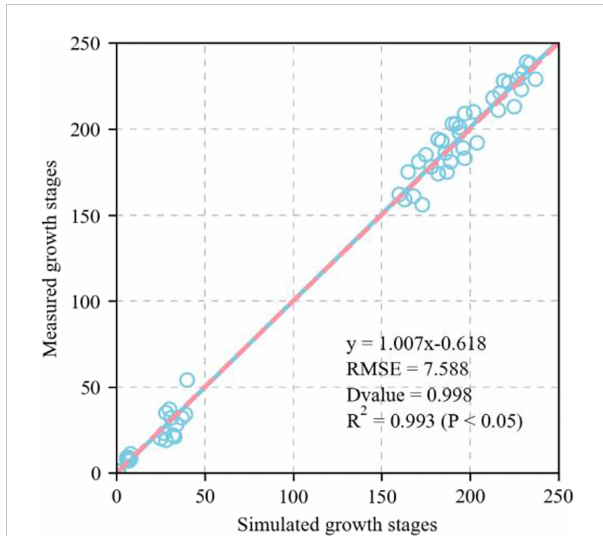
FIGURE 5 Evaluation of APSIM-Wheat model for modelling wheat growth stages (Zadoks growth stage) (1:1, dashed line), including emergence (Z10), three leaves (Z14), tillering (Z20), elongation (Z35), booting (Z45), heading (Z55), anthesis (Z65), medium milk (Z80), and maturity (Z100), at Xinxing station for evaluation dataset (2001 – 2007) (1:1, dashed line). Blue circle represents simulated and measured values. Straight line represents regression line of fi tting equation between measured and simulated value. RMSE is root mean square error which is used to measure deviation between observed and measured value. D-value is used to assess consistency between observed and measured value. R 2 is used to describe degree of fi tting of regression line to observed value. The closer R 2 is to 1, the better the fi tting. P < 0.05 means difference was highly signi fi cant. Zadoks growth stage is sourced from Zadoks et al.